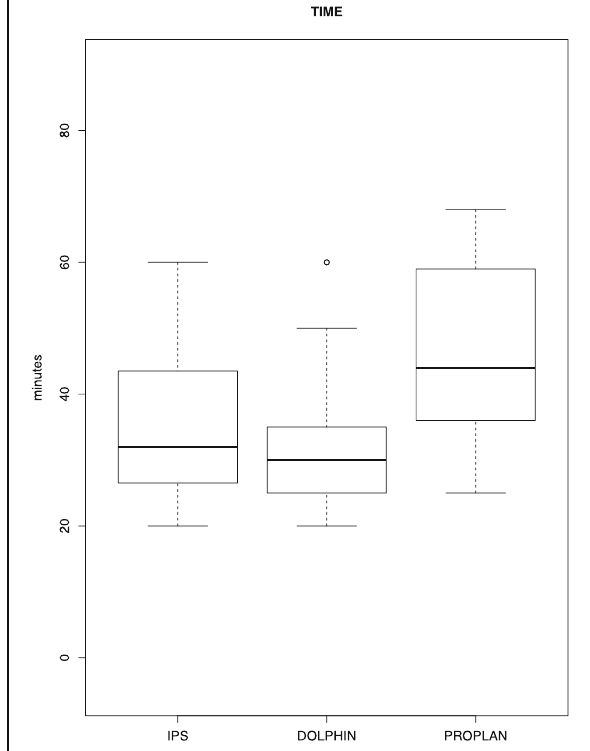
Fig. 6 Boxplot of time consumption in minutes for the software applications IPS Case Designer ®, Dolphin Imaging ® 11.95 and ProPlan CMF